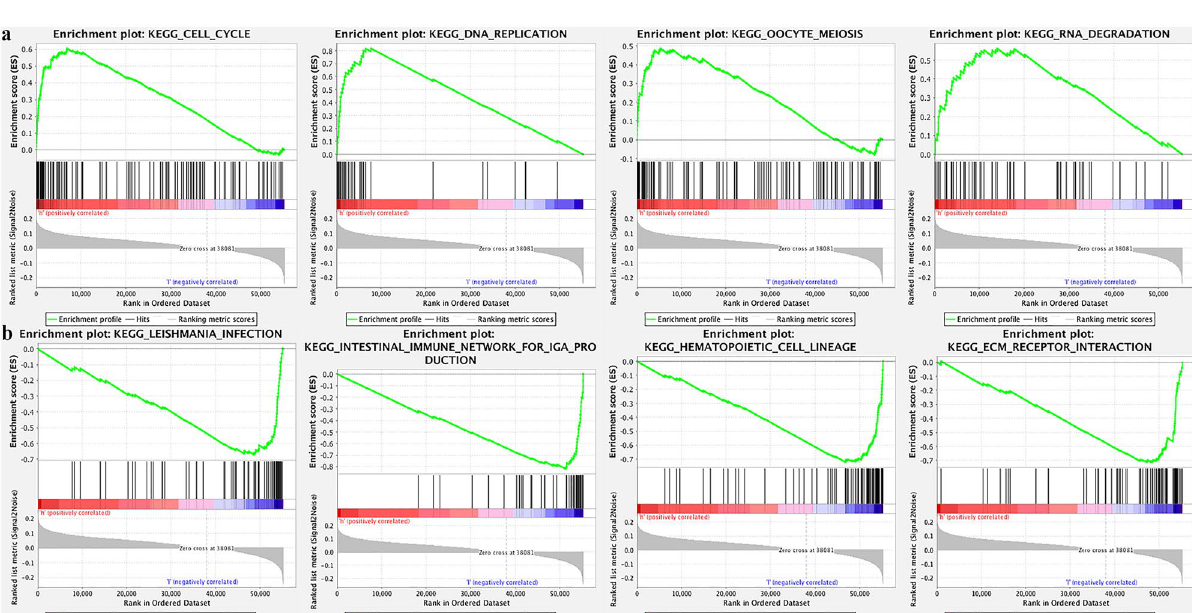
Figure 4. GSEA analysis was performed to further screen the significant pathway between high TMB group and low TMB group. The q ‐ value < 0.05 was considered as significance. ( a ) Significant pathway identified in the high-TMB group. ( b ) Significant pathway identified in the low-TMB